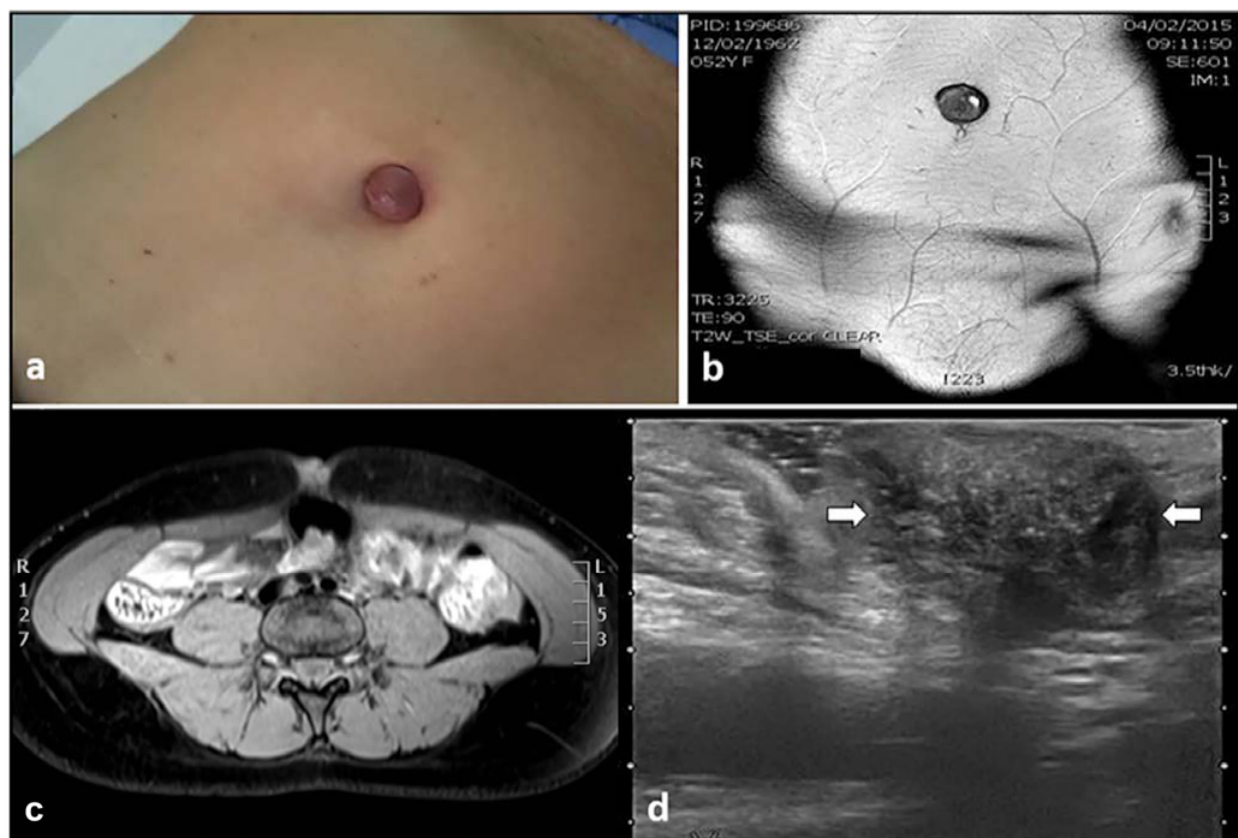
Figure 1. Umbilical mass, identified during physical examination ( a ), studied with MRI ( b , c ), and ultrasound imaging ( d ). White arrows in d revealed a hypoechoic hernial sac and intralesional hyperechoic spots, representing an umbilical hernia with endometriosis foci.